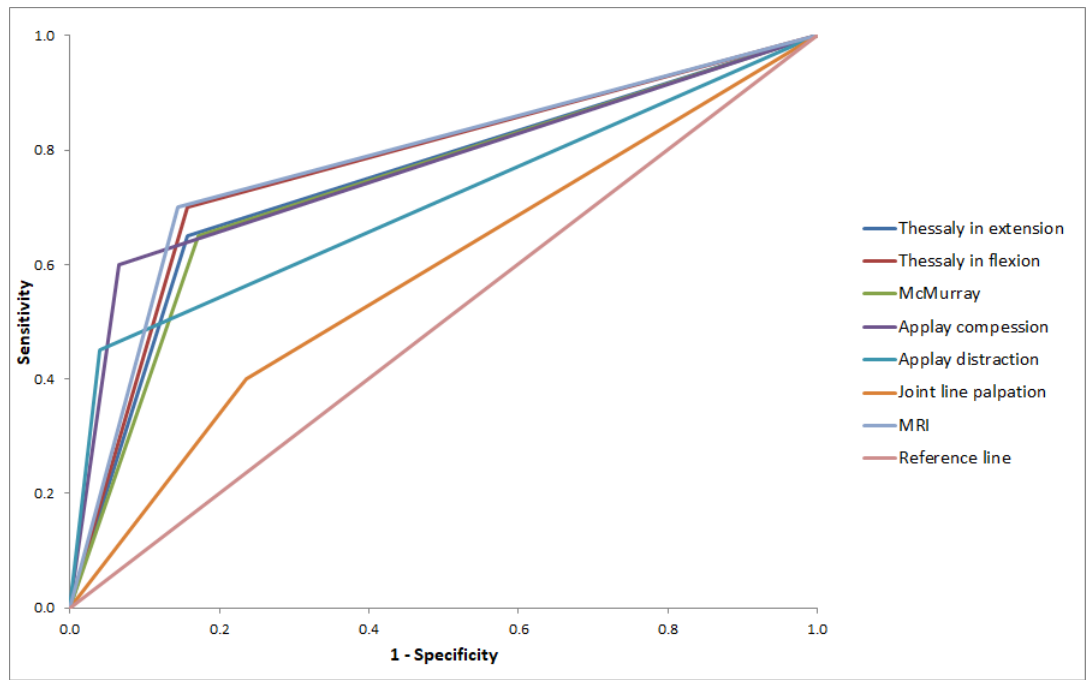
Figure 2. ROC curve describing relation of sensitivity to specificity in the diagnostic tests for lateral meniscus.